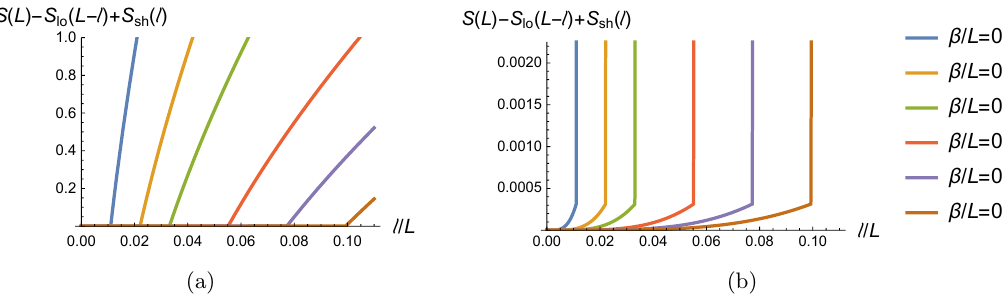
Figure 6 . Corrections to the entanglement plateau in 2D CFT. We just set c = 3 to plot the (cid:12)gures. From the left (cid:12)gure it seems suggest that the plateau is still there. The right (cid:12)gure shows (cid:1) S after zooming in around the zero. From the right (cid:12)gure, it is easy to see that the plateau disappears: (cid:1) S = 0 only when l !